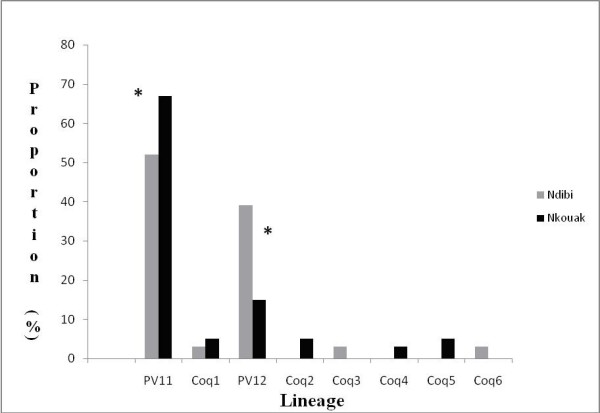
Proportion of infected pools of the eight Plasmodium lineages of Coquillettidia sppin Ndibi and Nkouak. Because sites sampled are more than 100 km apart, populations are considered independent. * indicates significant differences in proportion of infected pools between both habitats. Lineages PV11 and PV12 were the most common while the others were relatively rare.